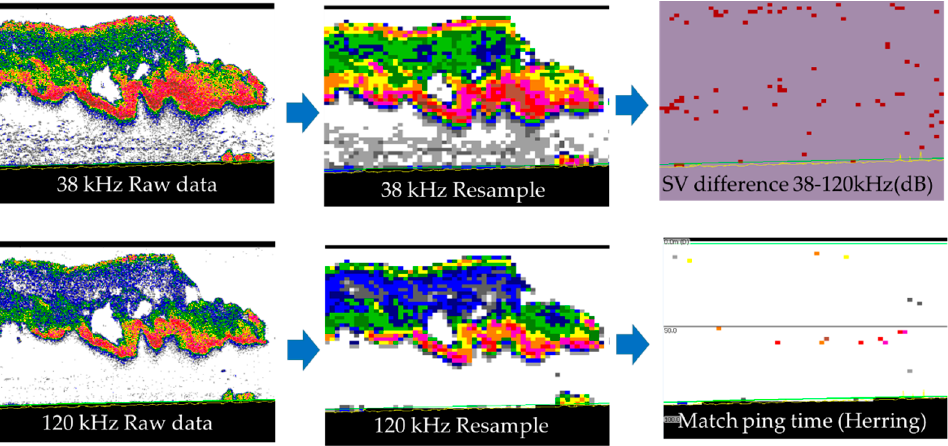
Figure 6. Herring identification example.